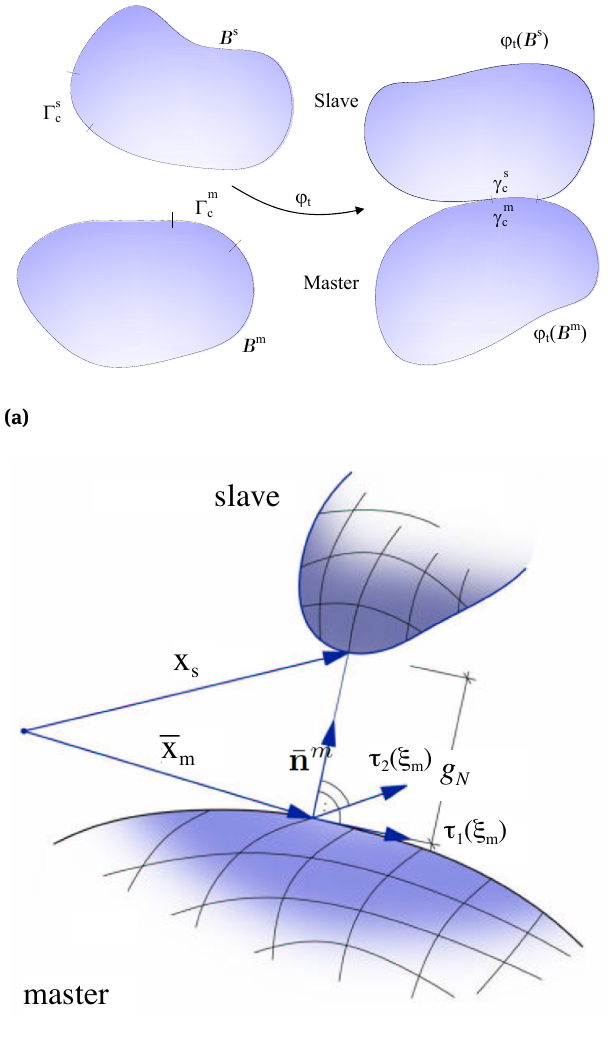
Figure 3: Geometrical variables for the contact formulation.